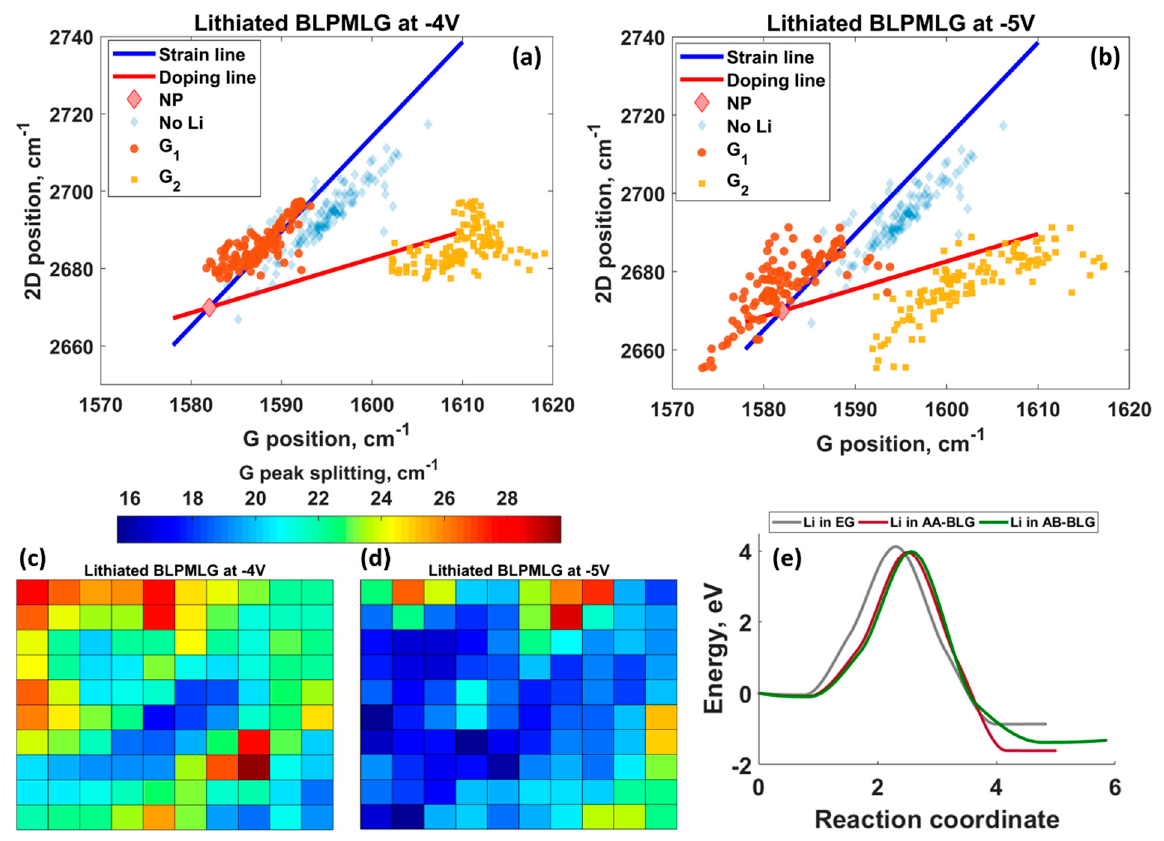
Figure 9. 2 D peak position vs. G peak position for bilayer-patched epitaxial graphene after lithiation at − 4 V ( a ) and − 5 V ( b ). The Raman data for bare bilayer-patched epitaxial graphene are also shown. The reddish diamond designated by NP represents the neutrality point of free-standing graphene, without doping and strain effects. Maps of G peak splitting values for electrodes lithiated at ( c ) − 4 V and ( d ) − 5 V. Each colored box represents one Raman spectrum. 121 Raman spectra per sample were analyzed to construct the maps. ( e ) CI-NEB energy curvatures for lithium penetrating beneath the topmost graphene layer in MLG/SiC, AA-BLG/SiC, and AB-BLG/SiC electrodes.